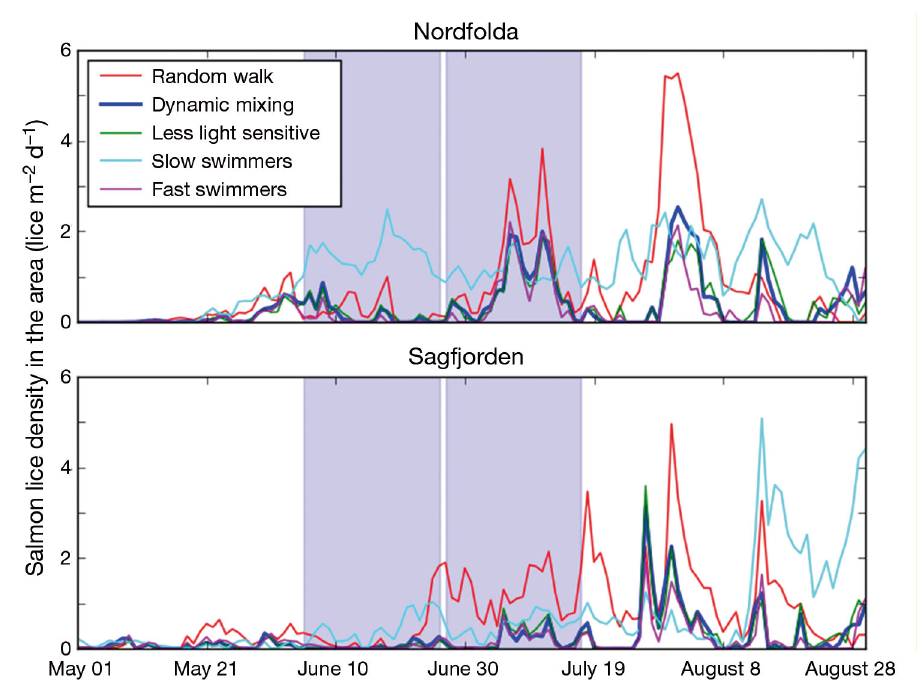
Fig. 8. Simulated density of sal mon lice Lepeophtheirus sal monis copepodids residing within the blue area in Fig. 1. Shaded area: assumed in - fection time for the captured wild